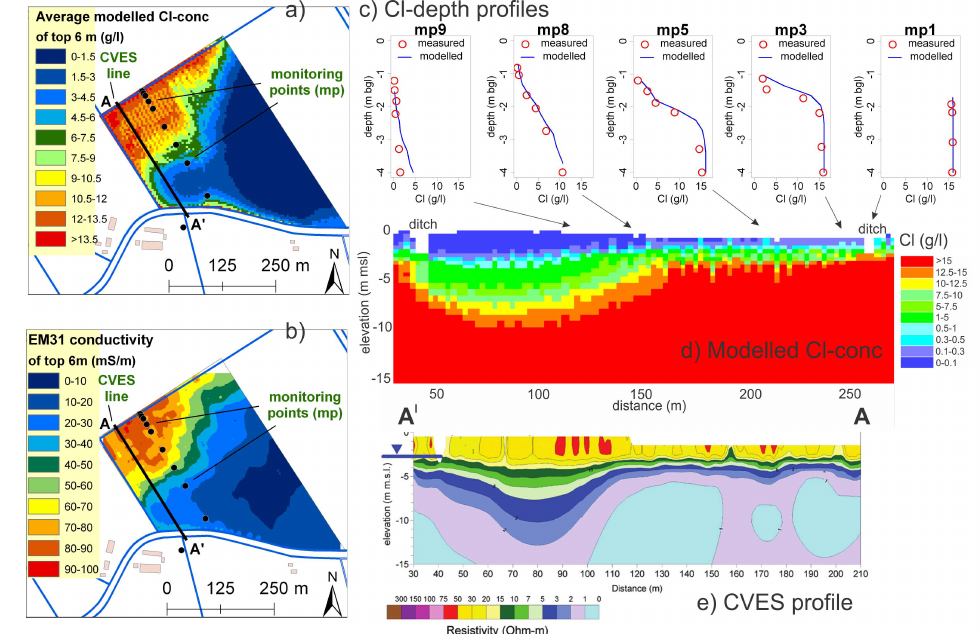
Fig. 10. Comparison of model results (3-D-model) with field measurements (EM13, Cl-depth profiles, CVES) for site 11.